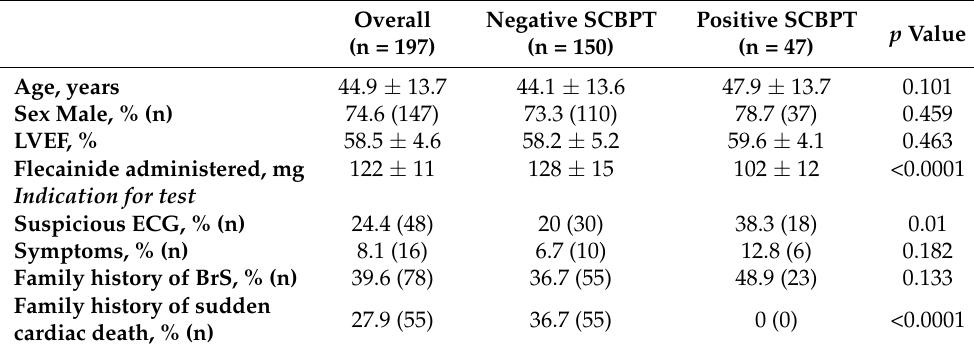
Table 4. Comparison of baseline clinical characteristics of the validation cohort based on Brugada syndrome diagnosis after Sodium Channel Blocker Provocation Test.